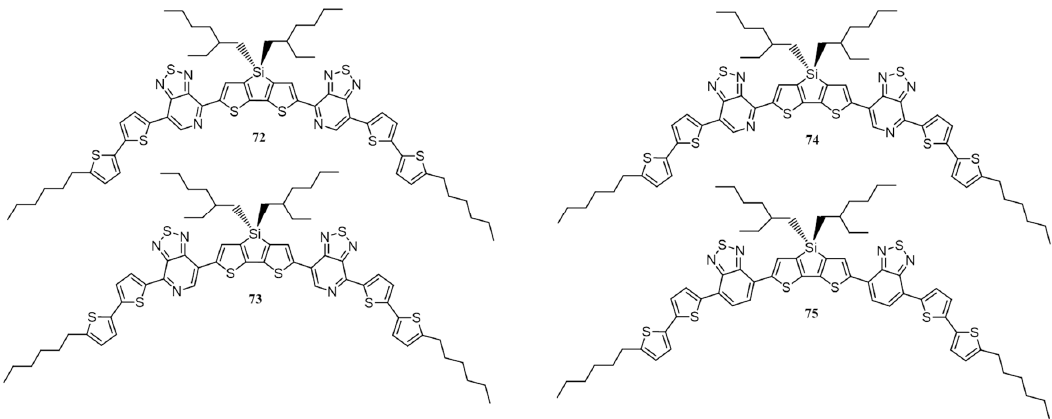
Figure 26. Molecular structures of compounds 72 – 75 synthesized by Heeger, Bazan et al. [91–93].